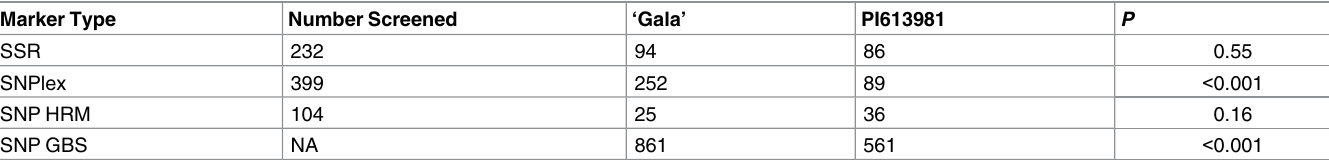
Table 3. Number of DNA markers screenedand found to be informative for the ‘Royal Gala’ and M . sieversii PI613981parents of the GMAL4593 mapping population. Marker